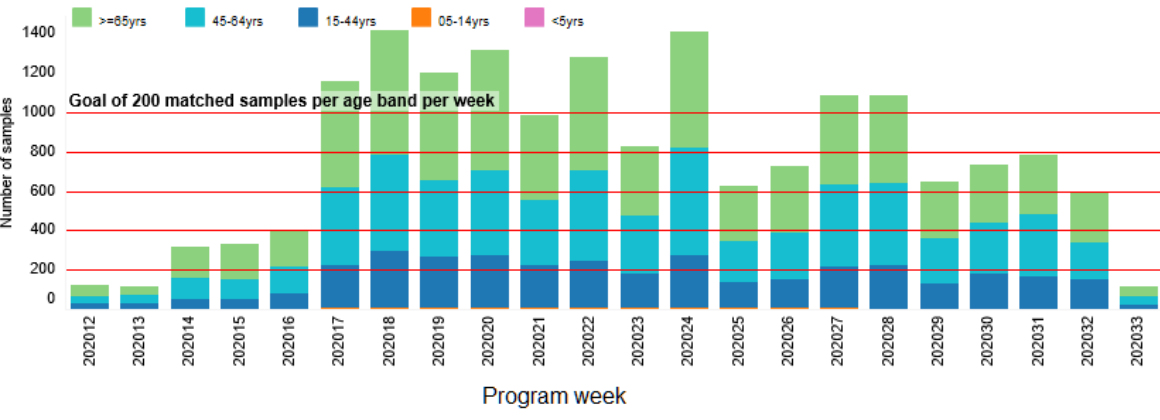
Figure 4. Number of serological surveillance samples collected per week. The program was initiated in week 11; we have been taking active steps to encourage similar numbers across age bands per